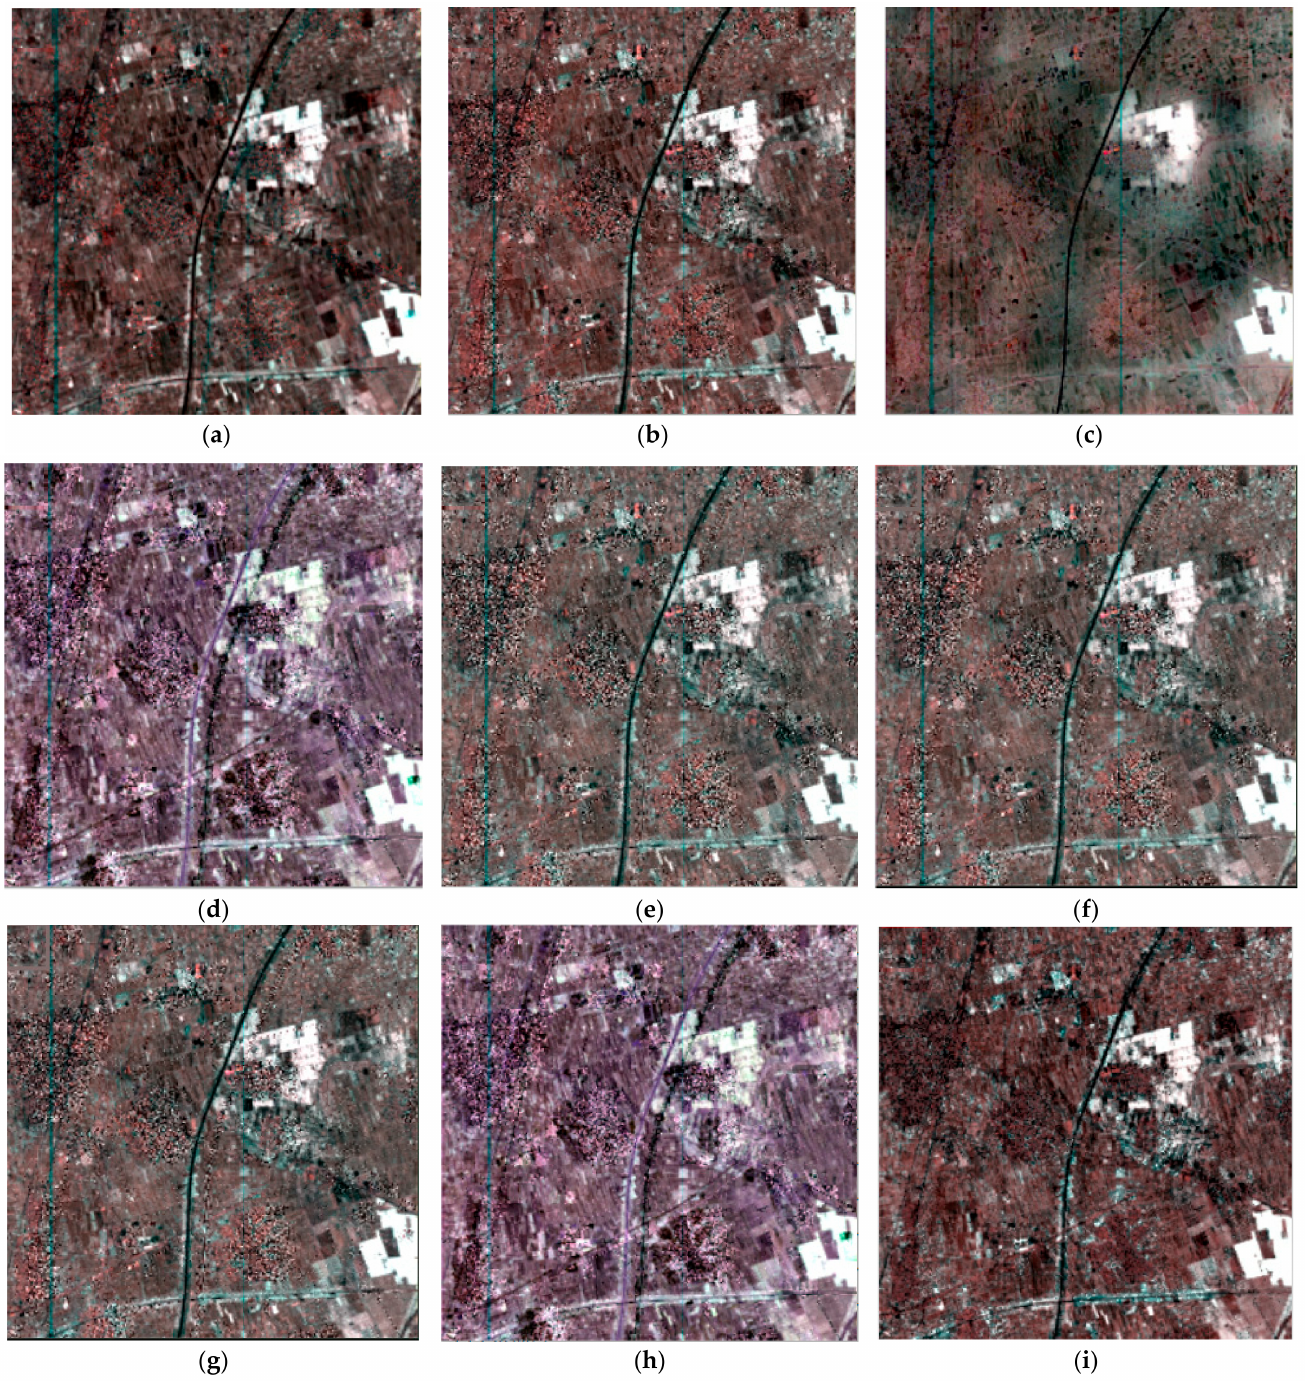
Figure 10. RGB images of ground truth, the different methods and the proposed EDRN method for the Baiyangdian dataset: ( a ) Ground truth, ( b ) AWLP, ( c ) CNMF, ( d ) GIHS, ( e ) MTF_GLP, ( f ) HPF, ( g ) SFIM, ( h ) DIP-HyperKite and ( i )